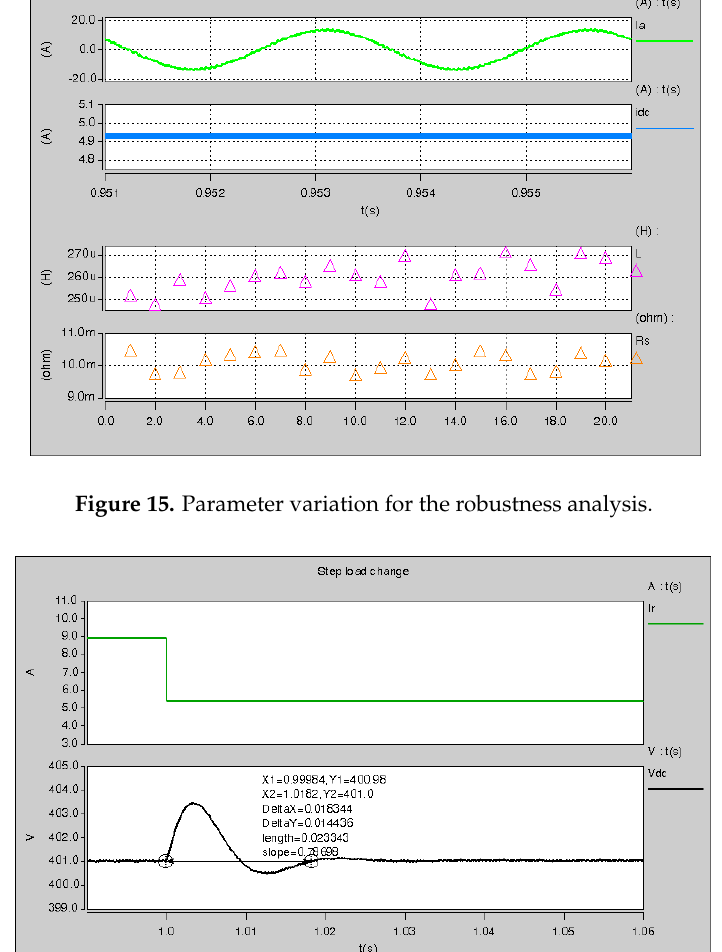
Figure 16. Step load change for the control system verification.